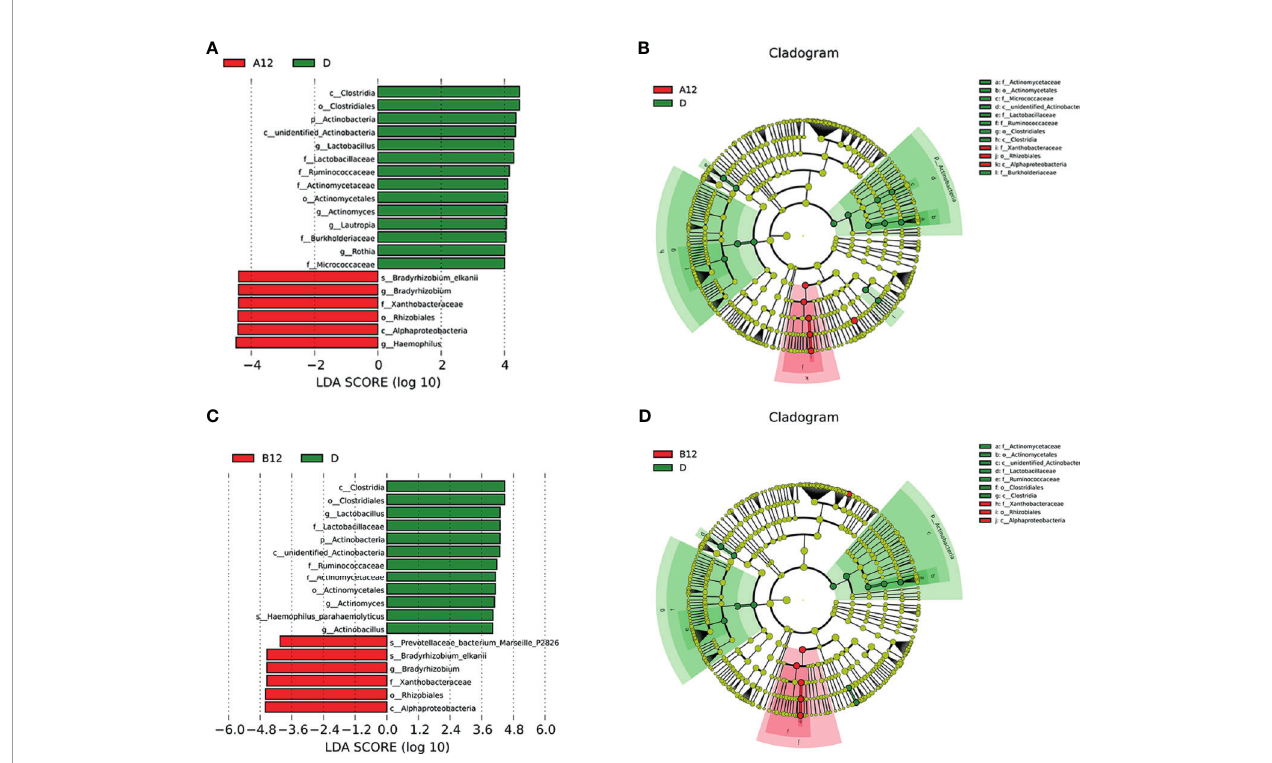
FIGURE 3 | Linear discriminative analysis (LDA) effect size (LefSe) at the genus level. (A, B) shown between A12 and D groups and (C, D) between B12 and D groups. In (A, B) , LDA scores for the signi fi cant taxa in D group are represented on the positive scale (green), and LDA-negative scores represent enriched taxa in A12 group (red); and in (C, D) , LDA scores for the signi fi cant taxa in D group are represented on the positive scale (green), and LDA-negative scores represent enriched taxa in B12 group (red). A12, people living with acute HIV infection after 12 weeks of ART; B12, people living with chronic HIV infection after 12 weeks of ART; D, HIV-uninfected